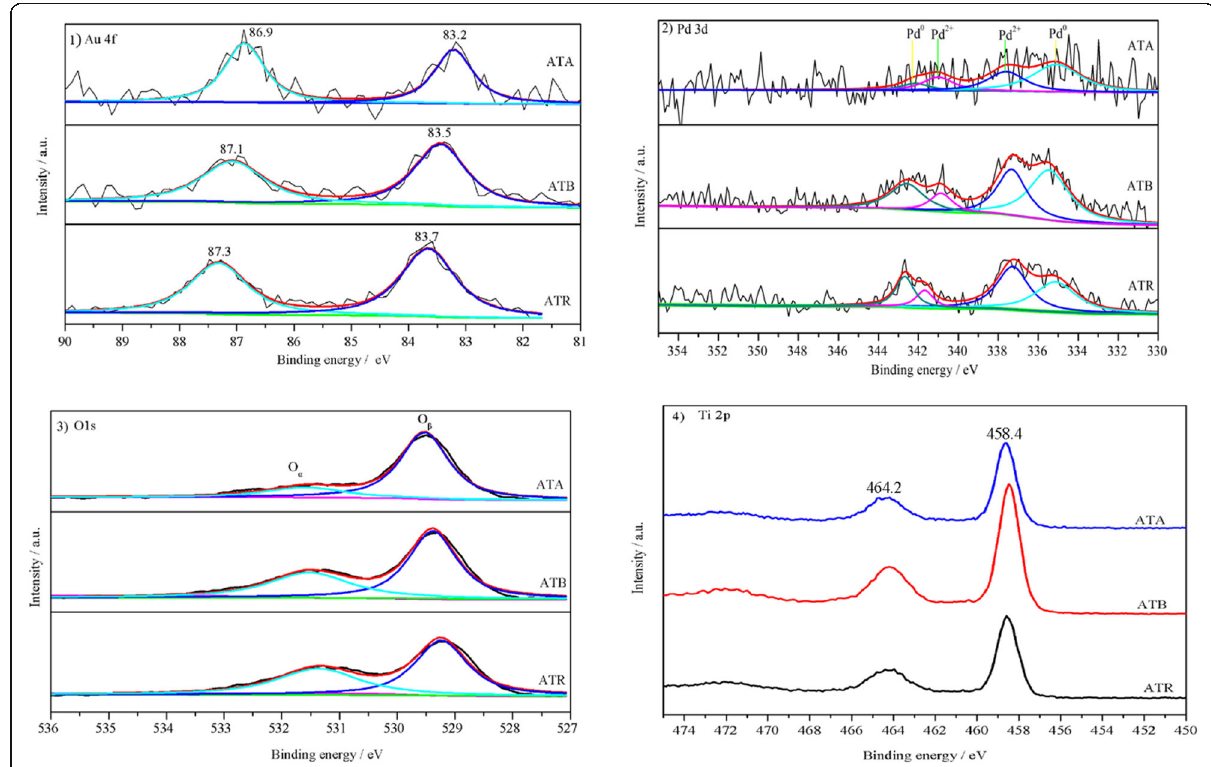
Fig. 2 XPS spectra of ( 1 ) Au 4f , ( 2 )Pd 3d, ( 3 ) O1s, and ( 4 ) Ti 2p) for the ATA, ATB, and ATR samples